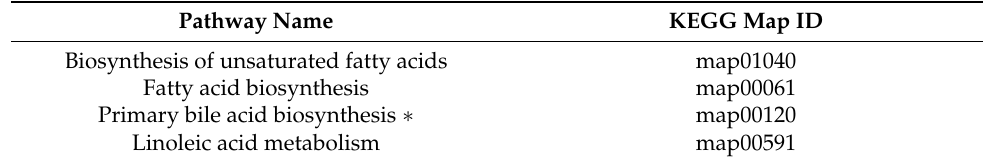
Table 2. Metabolic pathways of differential metabolites of D vs. M.